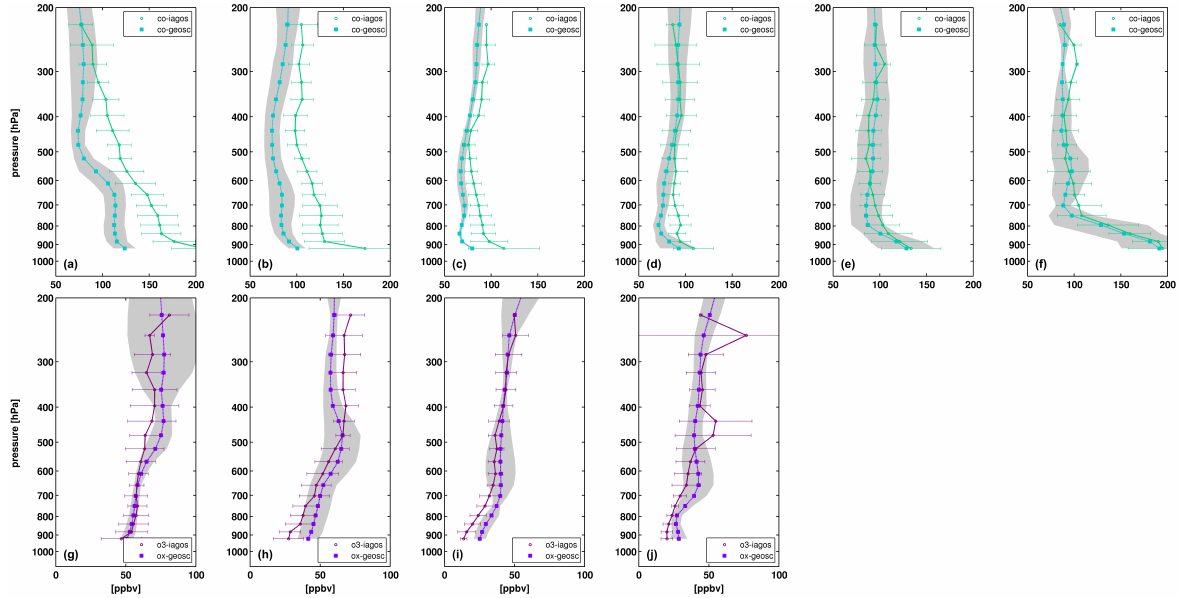
Figure 4. Monthly mean tropospheric vertical profiles of CO and O 3 at Hyderabad (17.2 ◦ N, 78.3 ◦ E) from MOZAIC-MOZAIC airborne observations and GEOS-Chem simulations. Top panels: CO from May to October 2009. Bottom panels: O 3 from May to August 2009. The grey shadings and the error bars represent the 1 σ variability for GC and MOZAIC respectively.